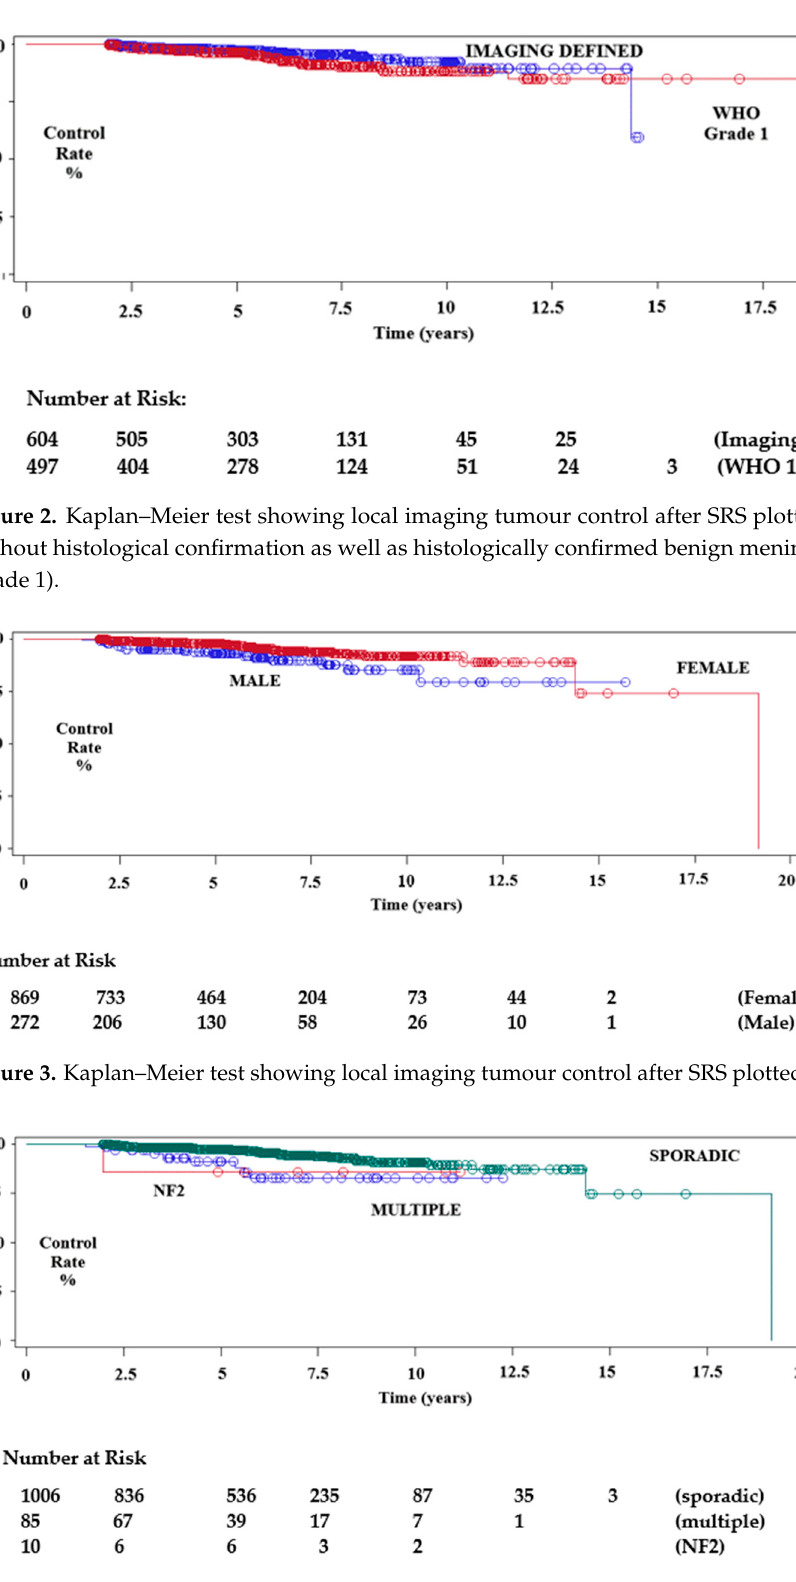
Figure 4. Kaplan–Meier test showing local imaging tumour control after SRS plotted by number of meningiomas treated.